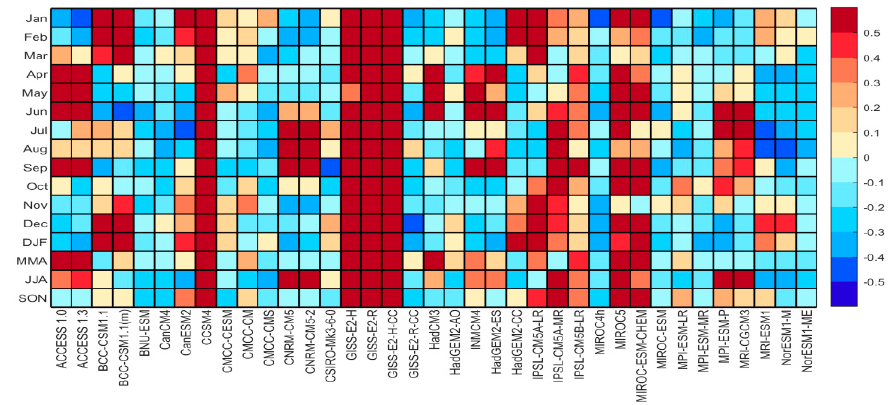
Figure 4. Area-averaged monthly and seasonal relative root mean square error (RRMSE) of precipitation relative to the observation for each CMIP5 model in Central Asia from 1986 to 2005.